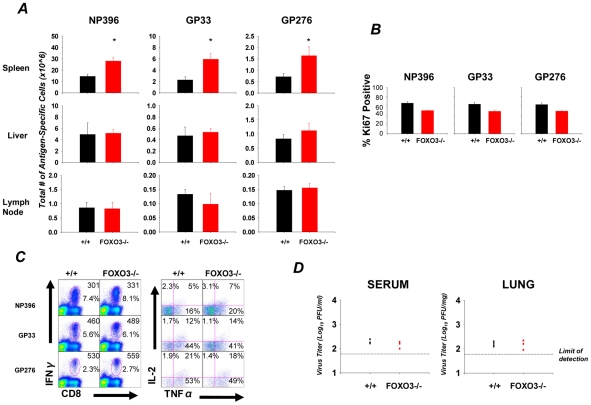
The secondary CD8 T cell response in FOXO3 deficient mice.+/+ and FOXO3−/− mice were infected with LCMV-Armstrong and after 90 days PI, these mice were challenged with 2.5×106 PFU of LCMV clone 13. (A) Five days after LCMV clone13 infection, mononuclear cells from spleen, liver and lymph nodes were collected and the total number of LCMV-specific CD8 T cells was determined by staining with anti-CD8 and LCMV-specific MHC-I tetramers. Data are from 4–6 mice/group; error bars represent the SEM and * indicates statistical significance at p<.05. (B) Splenocytes from +/+ or FOXO3−/− mice were stained with anti-CD8, MHC-I tetramers and anti-Ki67. The percentage of Ki67 positive cells amongst tetramer positive CD8 T cells was determined by flow cytometry. (C) Splenocytes were stimulated ex vivo with LCMV-specific peptides for 5 hours. Following stimulation, cells were stained for surface expression of CD8 and intracellular expression of IFNγ, IL-2 and TNFα. The top number in the plots on the left is the MFI of staining for IFNγ. The bottom number in the plots indicates the percentage of total splenocytes that are CD8 and IFNγ positive. The plots on the right are gated on IFNγ+ve CD8 T cells and the numbers are the percentages of cells that produced IFNγ and IL-2, IFNγ and TNFα, or IFNγ, IL-2, and TNFα. (D) LCMV titers in serum and lung were determined by plaque assay using a vero cell monolayer. Each symbol represents the viral titer of an individual mouse.